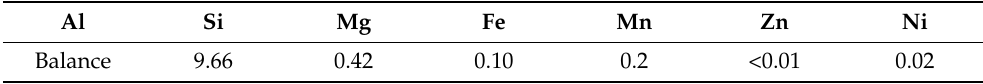
Table 1. Chemical composition of AlSi10Mg powders (wt%).